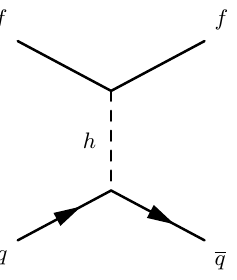
Figure 15 . Tree-level diagram contributing to WIMP-nucleon spin independent elastic scattering cross-section for fermionic